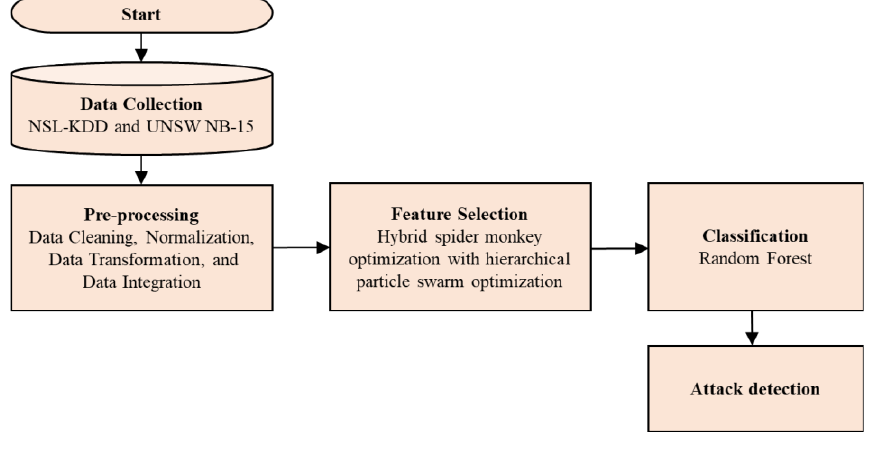
Figure 2. The block diagram of proposed SMO-HPSO feature selection method.